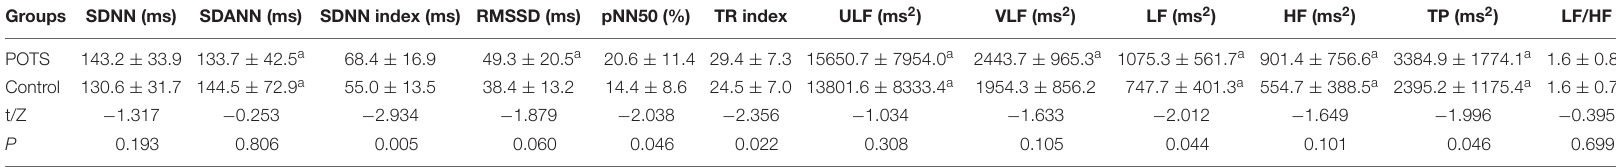
TABLE 2 | Comparison of HRV indices between POTS and control groups.